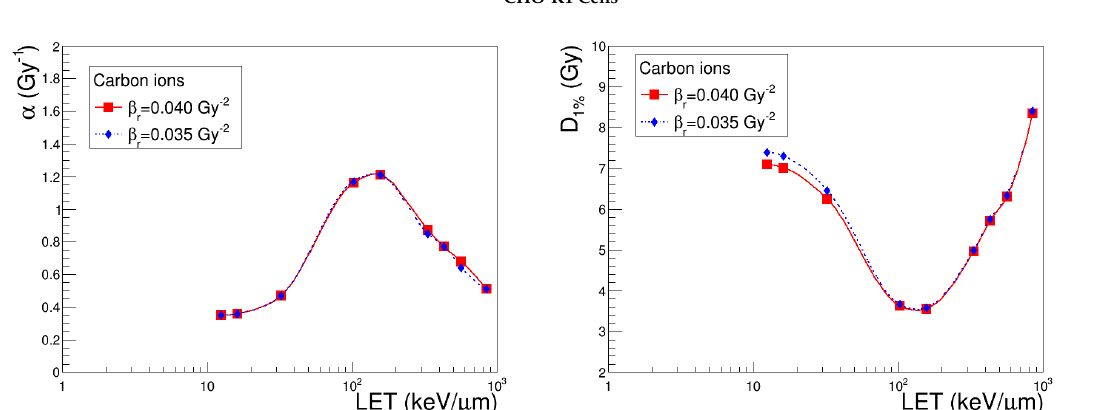
Figure 9. α and D 1% predicted by NanOx for the standard configuration (red curve) and for different β r values (blue curve), as detailed in Table 5. The full symbols correspond to the LET values for which the estimates were performed, while the lines are drawn just to guide the eye and do not represent a